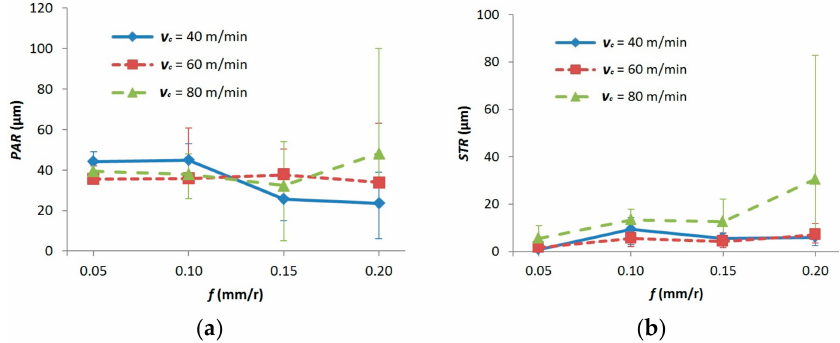
Figure 7. ( a ) Parallelism and ( b ) straightness deviation as a function of cutting speed ( v c ) and feed ( f ).